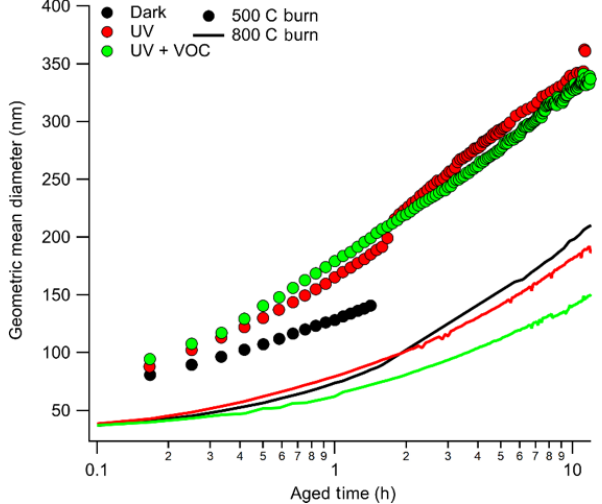
Figure 1. Growth of geometric mean diameter (GMD) as a func- tion of photochemical age for eucalyptus under different burn and aged conditions represented in the legend (black for dark aging, red for aging under light, and green for aging under light plus VOCs with a solid line for flaming-dominated combustion and filled cir- cles for smoldering-dominated combustion). Except for dark ag- ing conditions, zero time represents the time at which the light is turned on. For the lower-temperature case, initial GMD was typi- cally about 85–90nm, whereas for a higher-temperature burn it was below